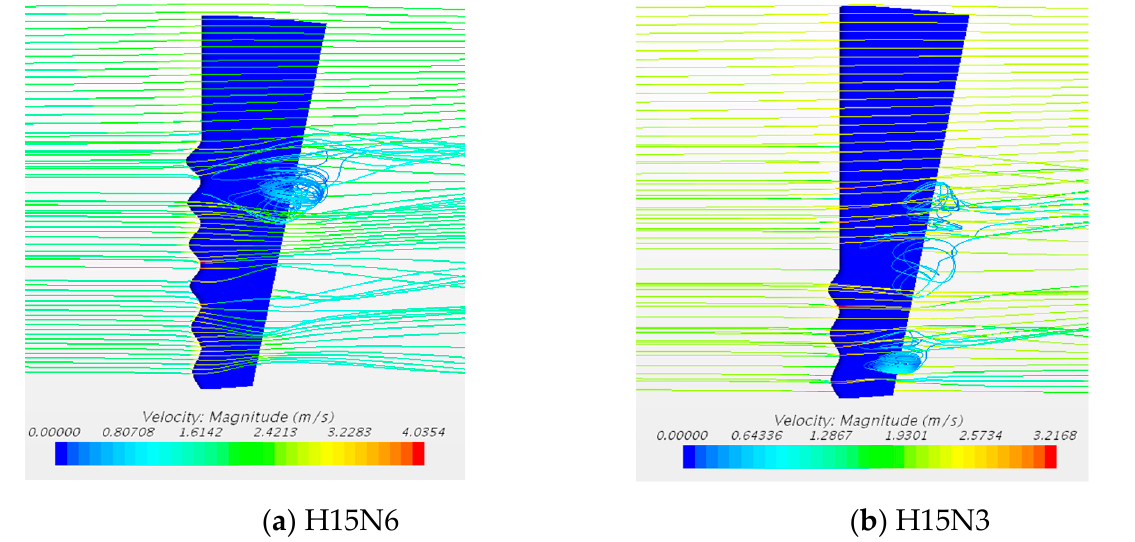
Figure 15. Streamlines near the surface of ( a ) H15N6 and ( b ) H15N3 when attack angle is 16°.